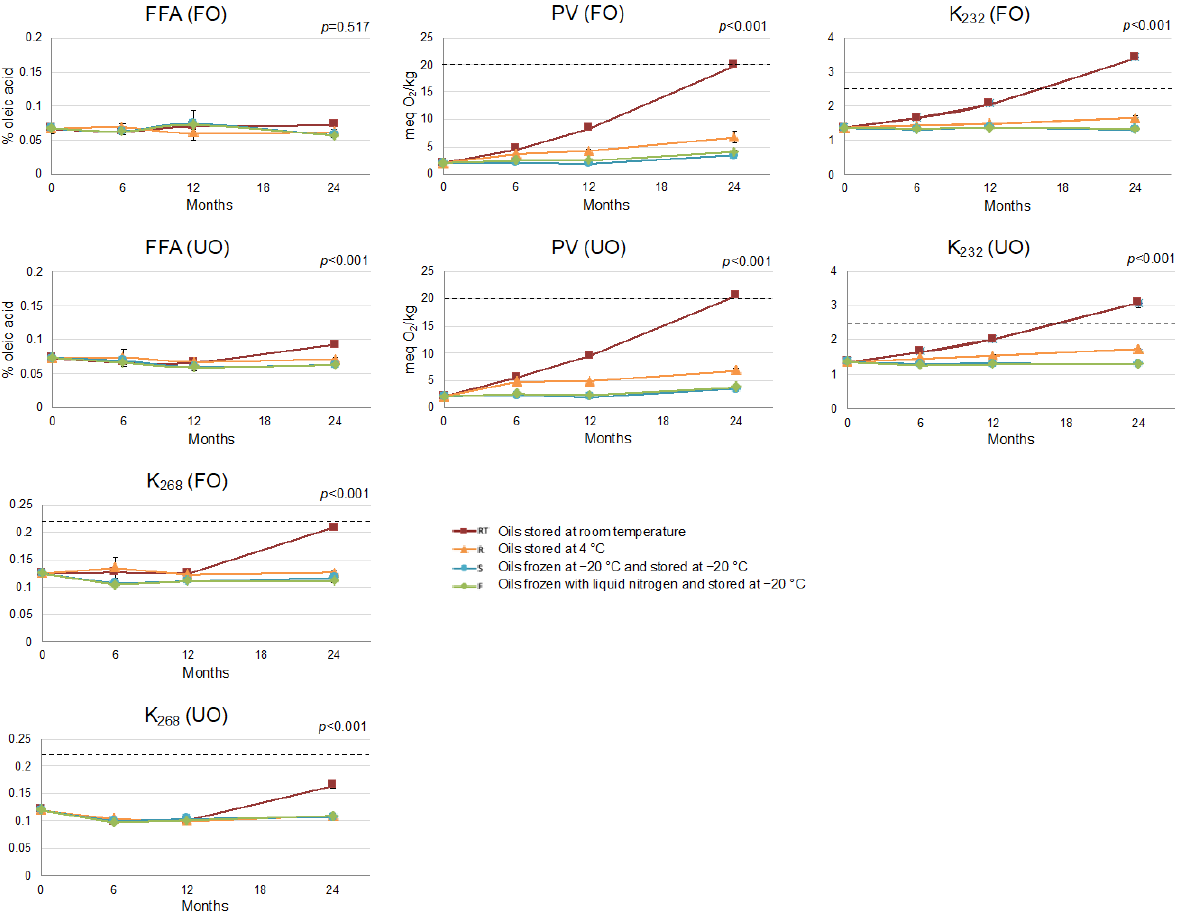
Figure 1. Interaction plot between storage conditions and time for % free fatty acids (FFA), peroxide value (PV), K 232 and K 268 of the filtered (FO) and the unfiltered (UO) oils. p ≤ 0.05 indicates significant interaction between the two factors (storage conditions and storage time). Error bars correspond to the standard deviation. The established limit for the EVOO category according to EC Regulations is marked by the dotted line.